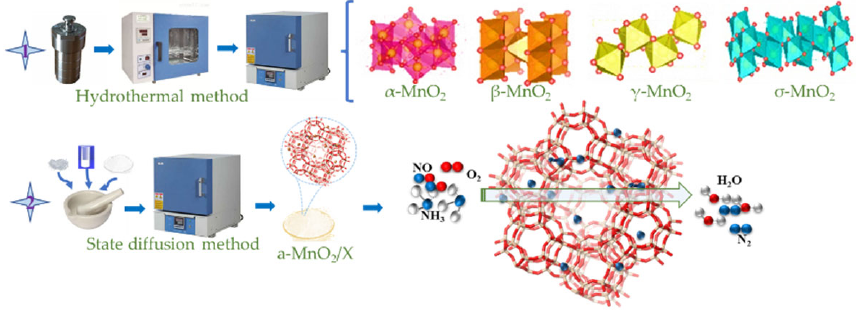
Figure 7. The synthesis procedures and experimental steps of α -MnO 2 /X, β -MnO 2 /X, γ -MnO 2 /X, and σ -MnO 2 /X catalysts.